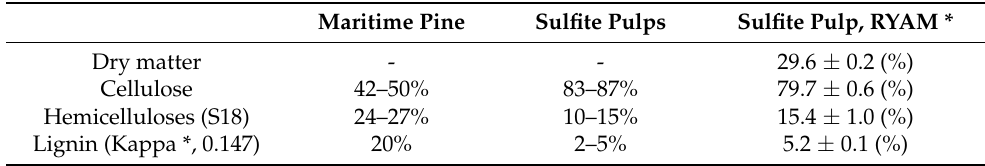
0.05.010.015.020.025.030.035.0